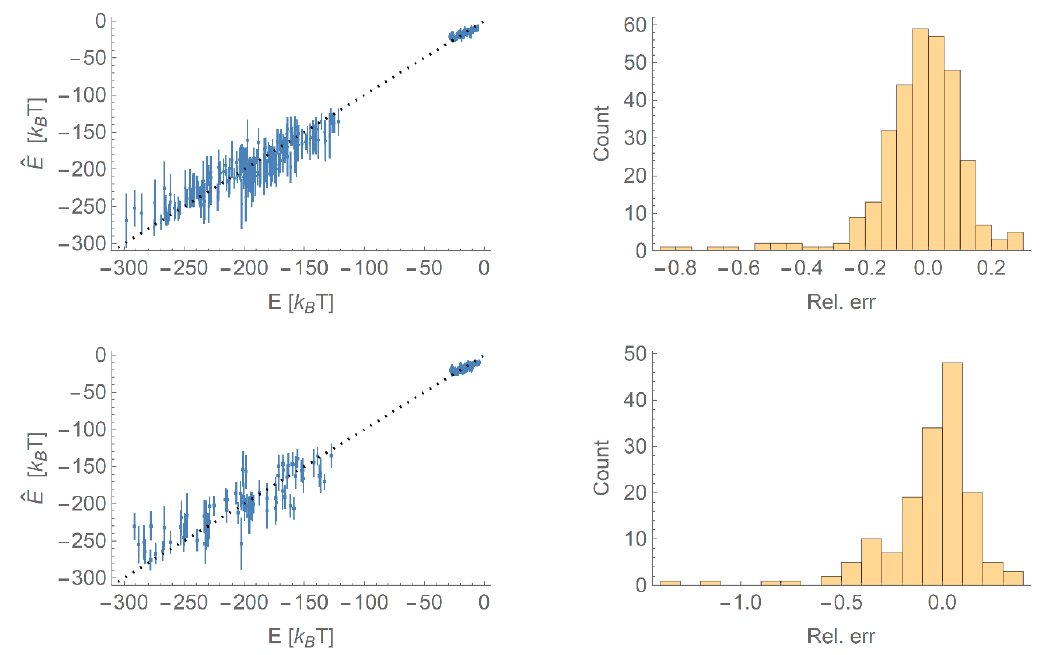
Figure 4. Top : A comparison of the binding energies predicted by the neural network ( ˆ E ) compared to the binding energies ( E ) used as input ( left ) and a histogram of the relative errors ( right ) for data points in the training set. Error bars indicate the standard deviation in the predicted values. Bottom : As top, except for points in the validation set.